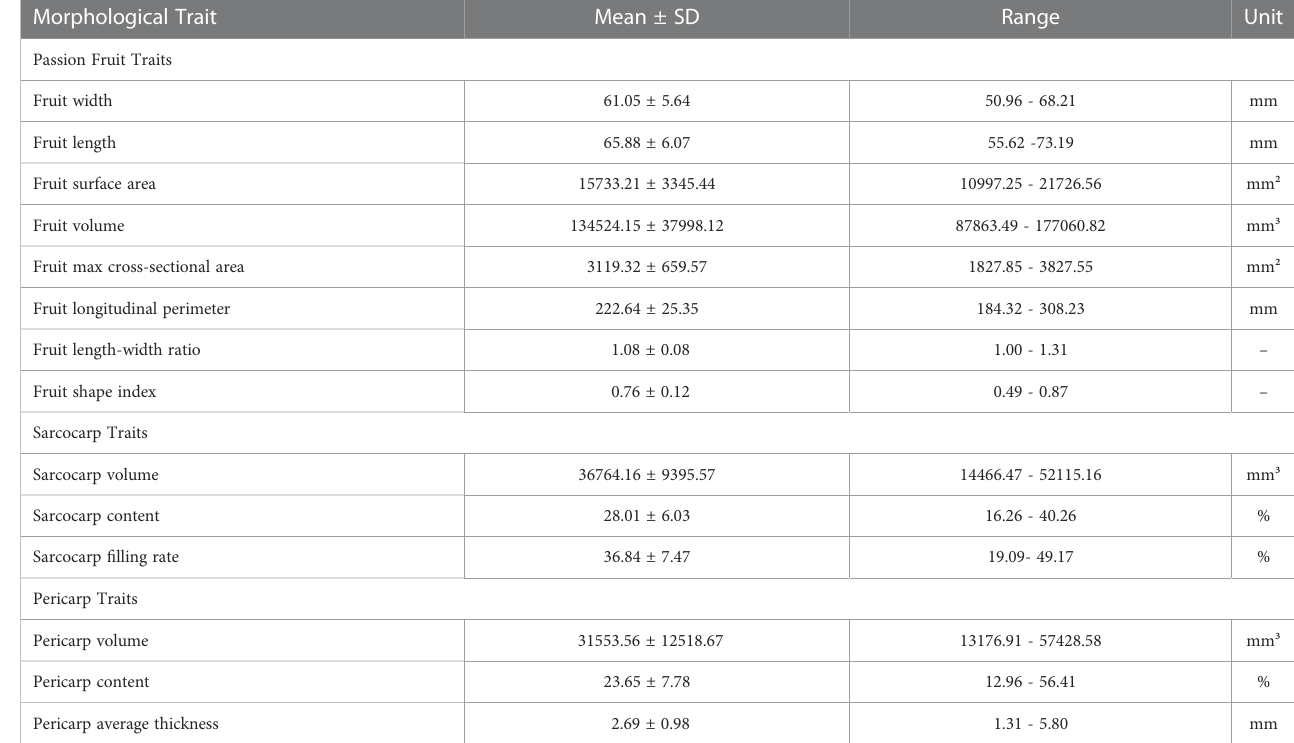
TABLE 2 Descriptive statistics of passion fruit morphological traits. Morphological